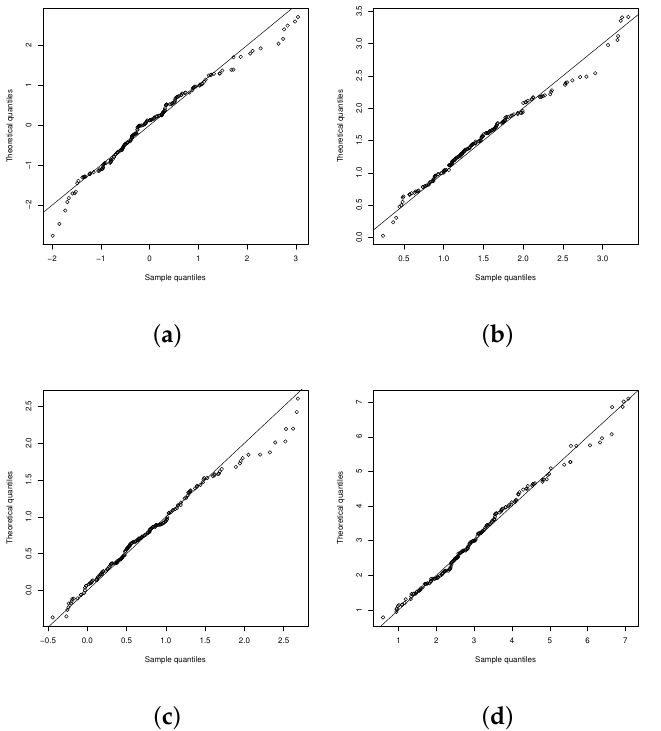
Figure 3. QQplots for ( a ) Normal model, ( b ) PN model, ( c ) SN model, and ( d ) LGN model fitted to the cholesterol